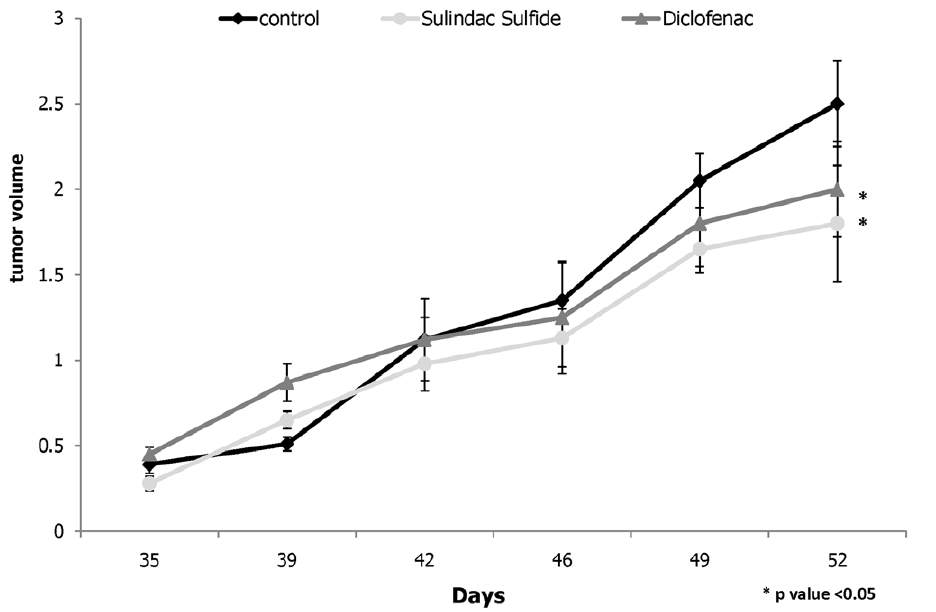
Figure 3. Reduction of tumor formation by NSAIDs. For each inoculation, 2 6 10 6 SKOV-3 cells were injected subcutaneously into SCID mice. The mice were randomly divided into three groups (n=7/group) and fed one of three diets through the entire experiment: AIN-93G as the control, the AIN-93G diet supplemented with 200 ppm Sulindac Sulfide or the AIN-93G diet supplemented with 100 ppm Diclofenac. The size of the tumors and tumor weight were measured after 2 months. Values not sharing the same letters are statistically significant with p values at least ,